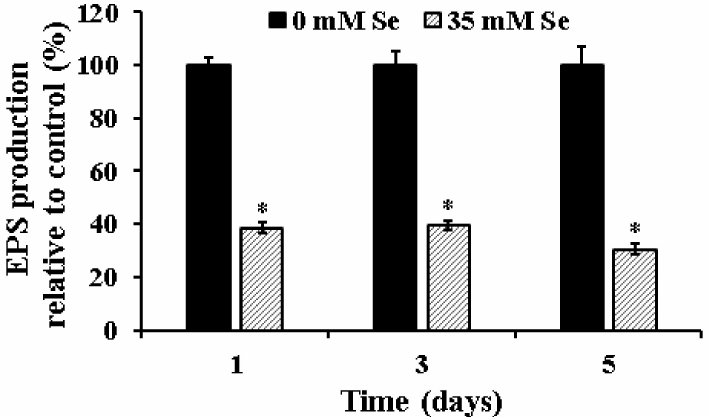
Figure 2. Effect of selenium on exopolysaccharide (EPS) production by UPEC. Sterile 96-well polystyrene tissue culture plates were inoculated with 200 µ L of the cell suspension (~6.0 log CFU) followed by the addition of 0 or 35 mM selenium. The plates were incubated at 37 ◦ C. Following 1, 3, and 5 days of exposure, EPS production was assayed by staining the wells with 0.01% ruthenium red and recording the absorbance at 450 nm. Data are represented as mean ± SEM. * Treatments are significantly different from the control at p ≤